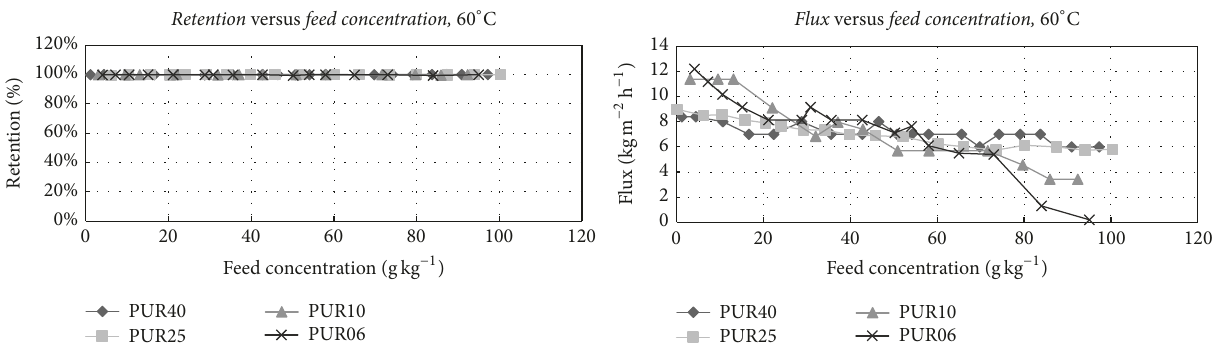
Figure 5: Retention and flux profile at different salinities at 60 ∘ C of feed